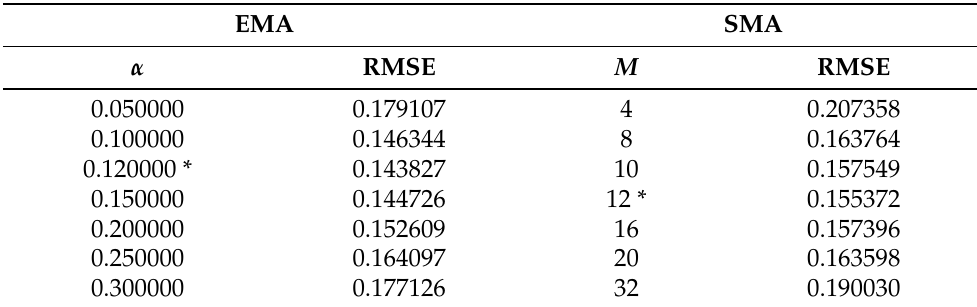
Table 2. RMSE for (cid:101) c estimations with EMA and SMA filters (ˆ (cid:101) EMA c and ˆ (cid:101) SMA c ). EMA SMA α RMSE M